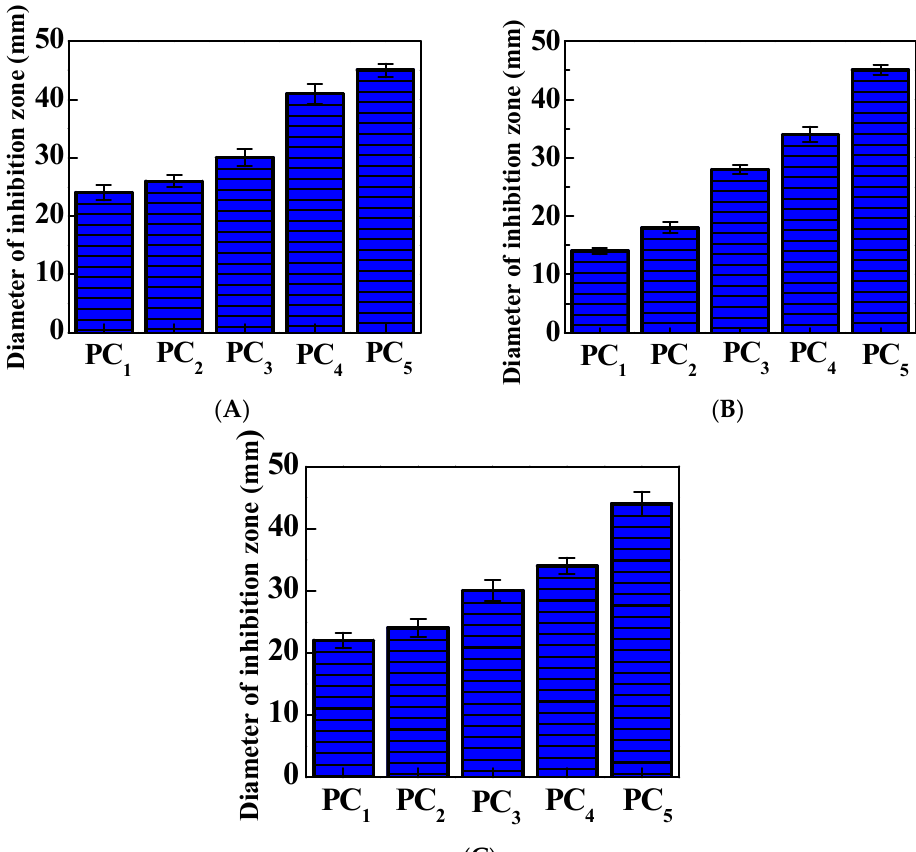
Figure 6. Average diameters of inhibition zones of PC composite films: ( A ) E. coli , ( B ) C. albicans , ( C ) S. aureus .